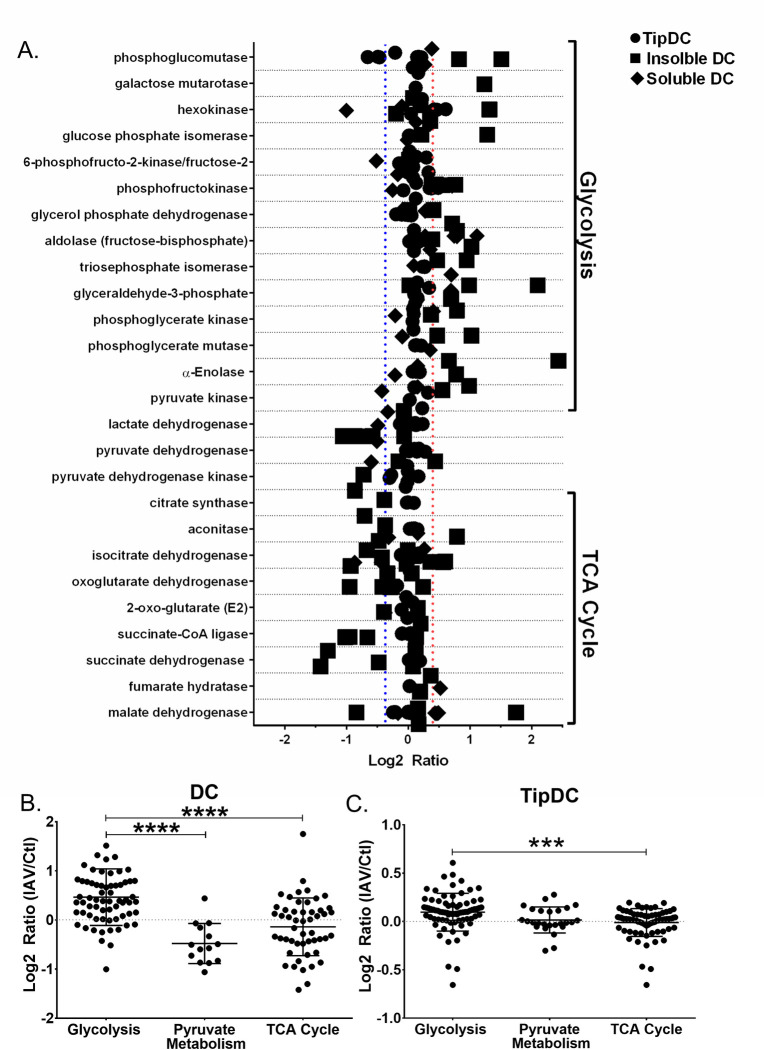
Dendritic cells globally reprogram metabolism in response to IAV infection.Proteins were extracted from in vitro differentiated uninfected and infected DC, separated into insoluble and soluble fractions, and subjected to mass spectrometry. RNA was extracted from lung TipDC on day 0 or 9 of IAV infection and subjected to RNA-Seq. The log2 ratio (IAV/Ctl) of transcripts and peptides were determined. Identifiers were converted to gene symbols and official protein names, each dataset were manually searched for all NCBI listed genes and synonyms corresponding to the major regulatory enzymes of glycolysis, pyruvate metabolism, and TCA cycle. (A) All isoforms of each enzyme were grouped (y-axis) and log2 ratios plotted. (B) Peptides, from the in vitro DC proteome, of enzymes were grouped into glycolysis, pyruvate metabolism, and TCA cycle. (C)TipDC transcripts were grouped into glycolysis, pyruvate metabolism, and TCA cycle.